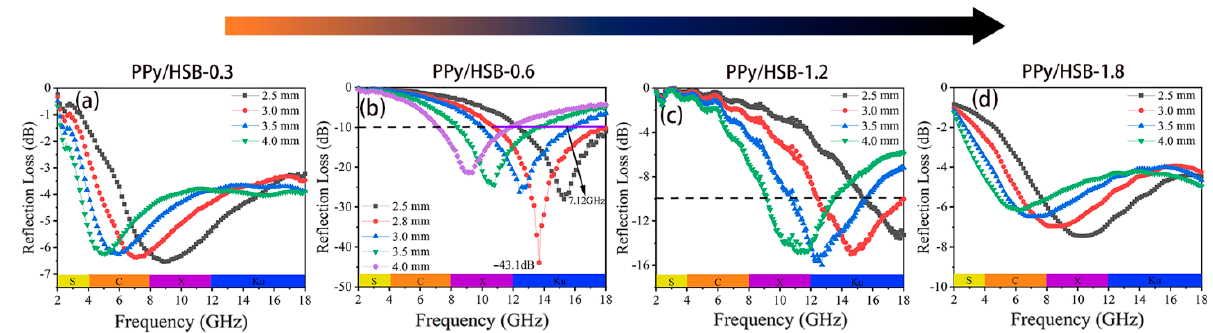
Figure 6. The reflection loss of the PPy/HSB composites. ( a ) PPy/HSB-0.3, ( b ) PPy/HSB-0.6, ( c ) PPy/HSB-1.2 and ( d ) PPy/HSB-1.8.